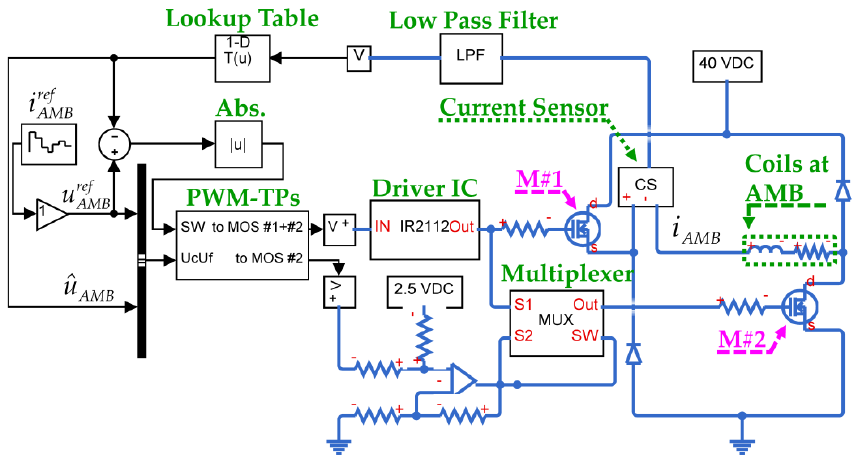
Figure 8. Simulink model of DC 2 (dual cooperative drive circuit). Table 1. Environmental setup of simulations.